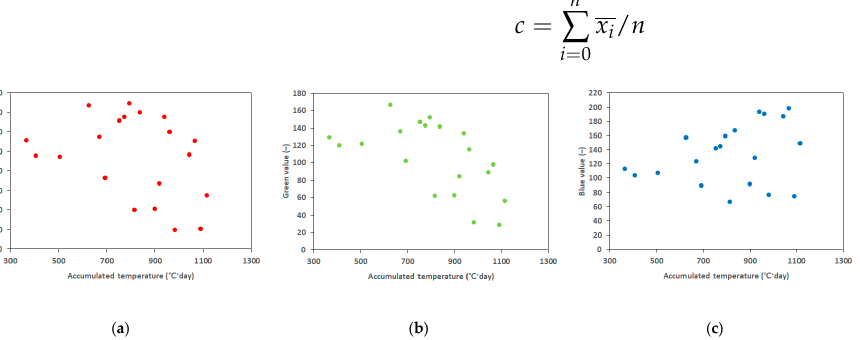
Figure 6. Correlation between the accumulated temperature and each RGB channel: ( a ) the red channel; ( b ) the green channel; ( c ) the blue channel.